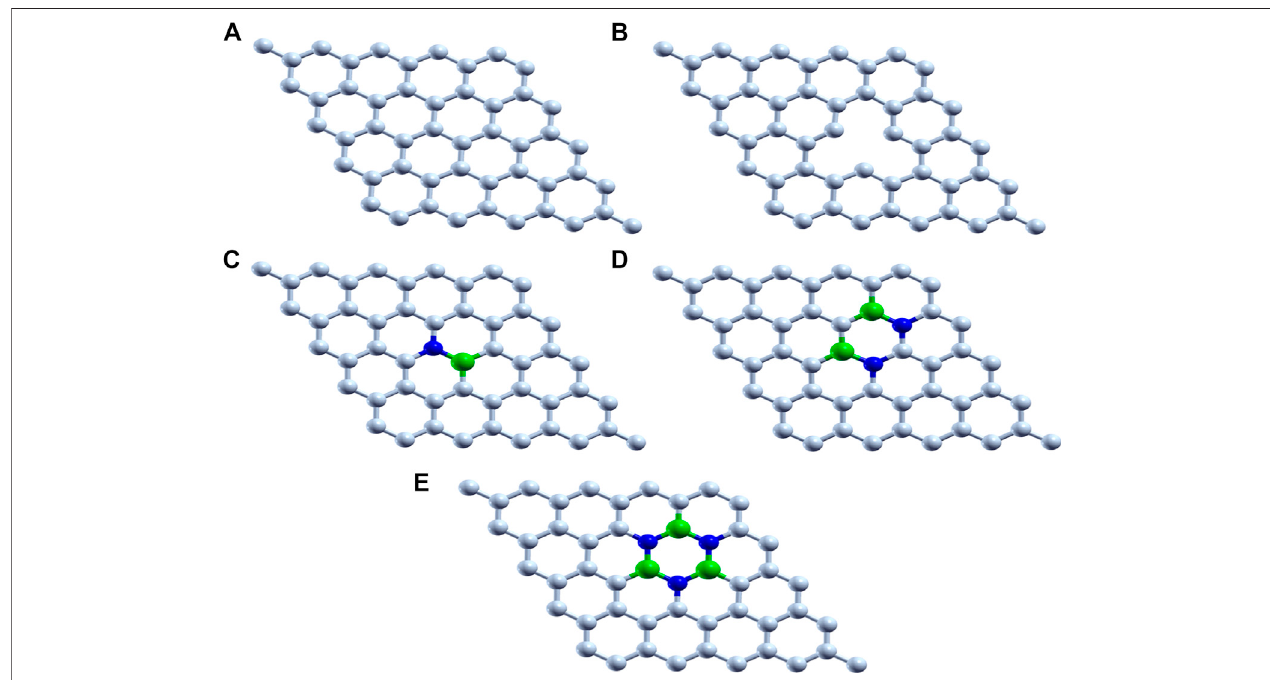
FIGURE 1 | Optimized structure of (A) pristine graphene, (B) defective graphene, (C) BN-doped graphene, (D) BNC-ring graphene, and (E) BN-ring graphene (C, white; B, green; and N, blue).